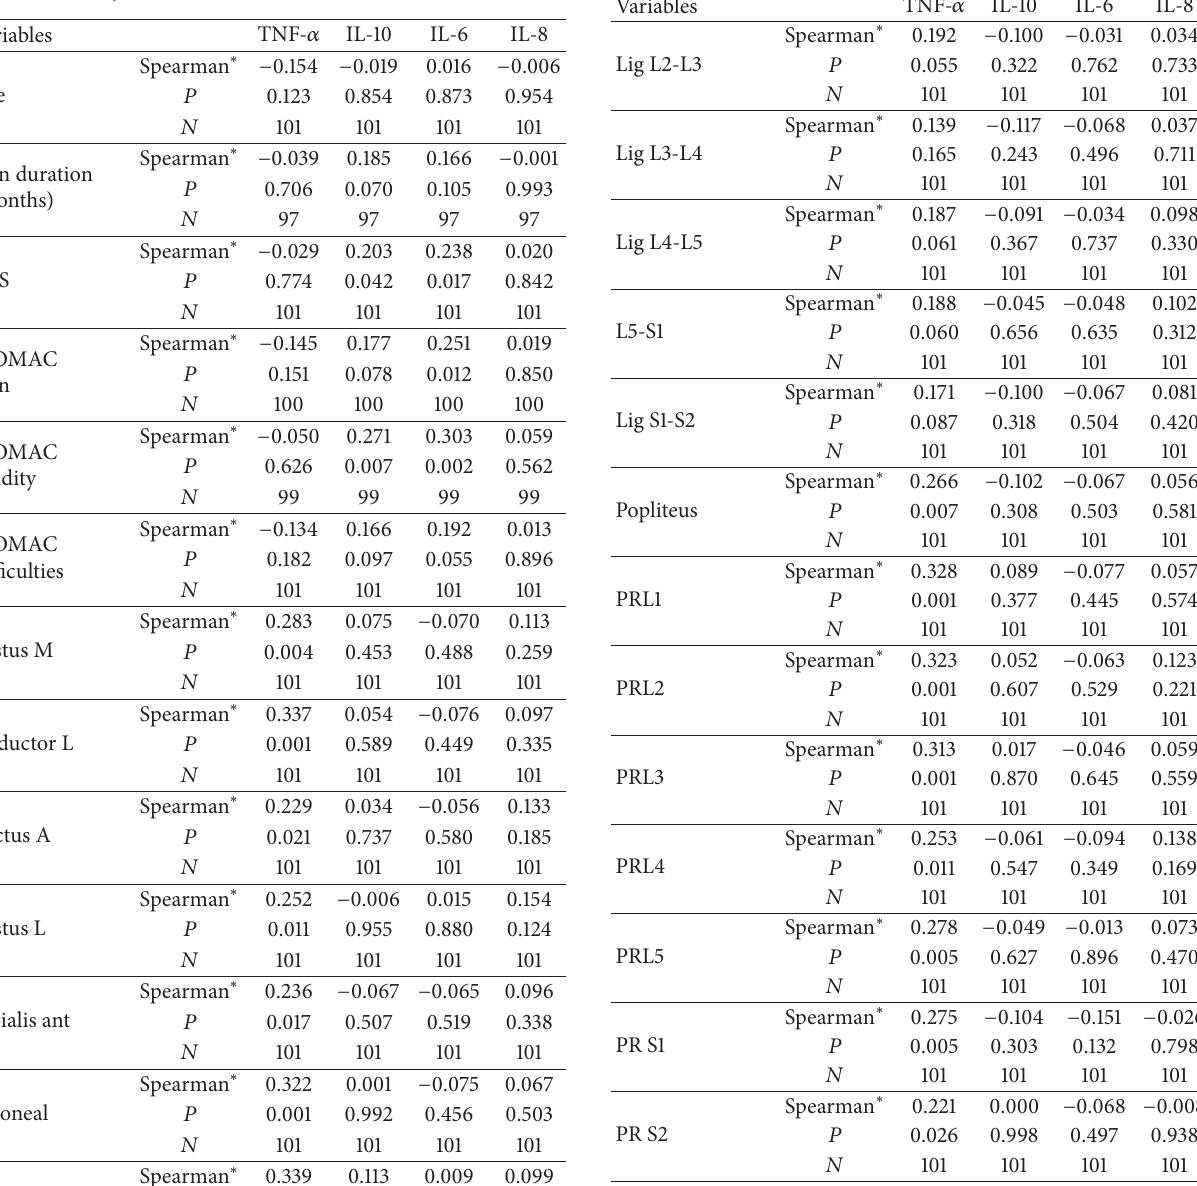
Table 4: Correlation among cytokines, age, pain duration, VAS, WOMAC scores, and PPT values over 24 anatomical